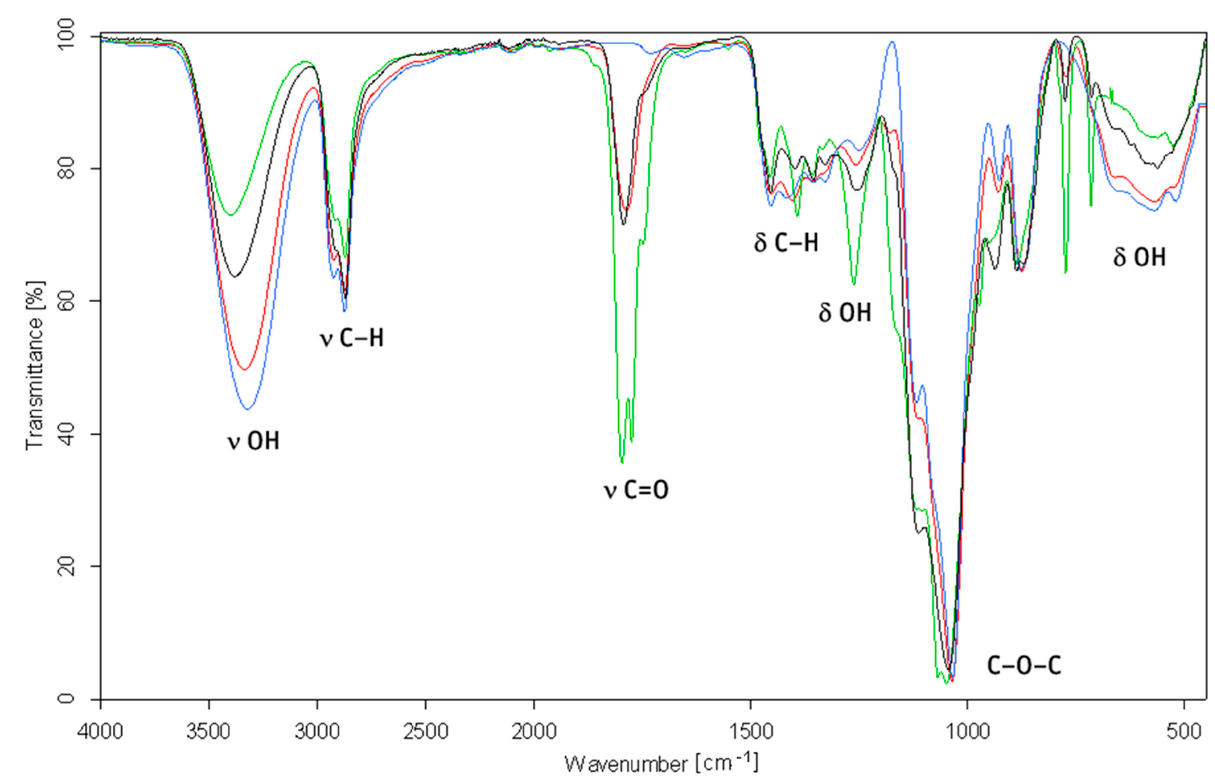
Figure 2. IR spectra of polyols (CS + H 2 O + GL) + EC (red), (CS + GLYC + GL) + EC (blue), (CS + GL) + EC (green), and (CS + GL + EC) (black).